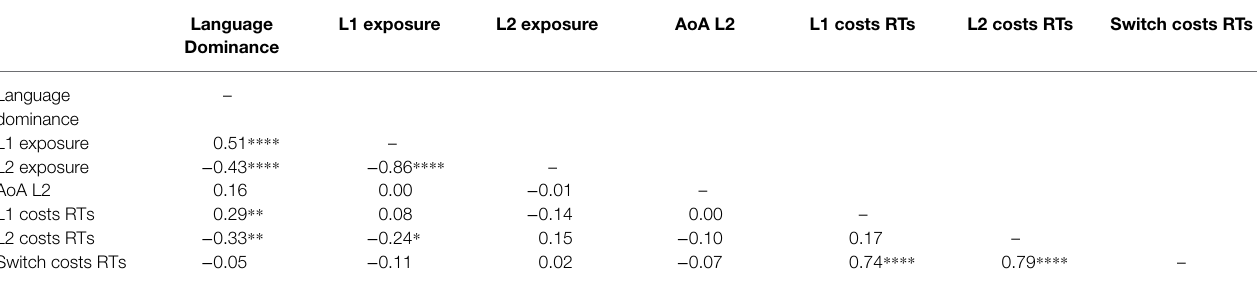
TABLE 6 | Bilingual’s Pearson correlation analyses between Language Dominance, recent exposure, initial age of L2 acquisition (AoA L2) and switching performance in the picture naming task in terms of response times (RTs).